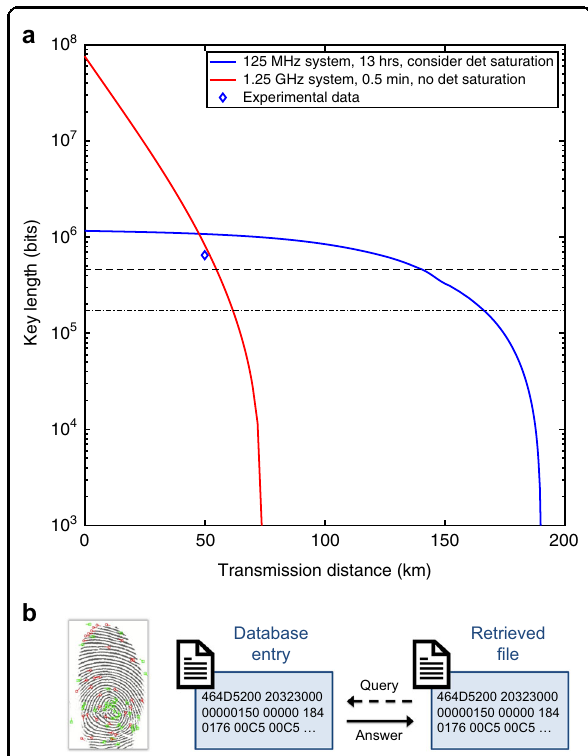
Fig. 3 Simulation and experimental result of the MDI QKD system. a The blue curve is the simulated secure key length with N ¼ 5 : 85 ´ 10 12 signal pulses (13 h operation of 125 MHz system) and with detector saturation under consideration. The red curve is the simulated secure key length with N ¼ 3 : 75 ´ 10 10 signal pulses (0.5min operation of 1.25 GHz system) and with no intensity limitation for quantum state preparation. The dotted lines indicate the number of keys required for the fi ngerprint database (4 : 66 ´ 10 5 shared bits of randomness between data centres and 1 : 72 ´ 10 5 shared secret bits between the user and each data centre). b Demonstration of the fi ngerprint